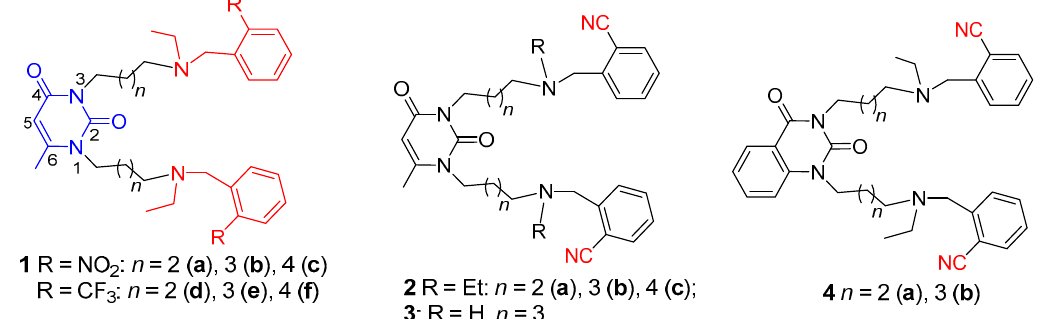
Figure 1. Structures of previous reported acetylcholinesterase (AChE) inhibitors 1a – f with 6-methyluracil, nitro-, and trifluoromethyl moieties [25] and herein reported AChE inhibitors 2a – c, 3,